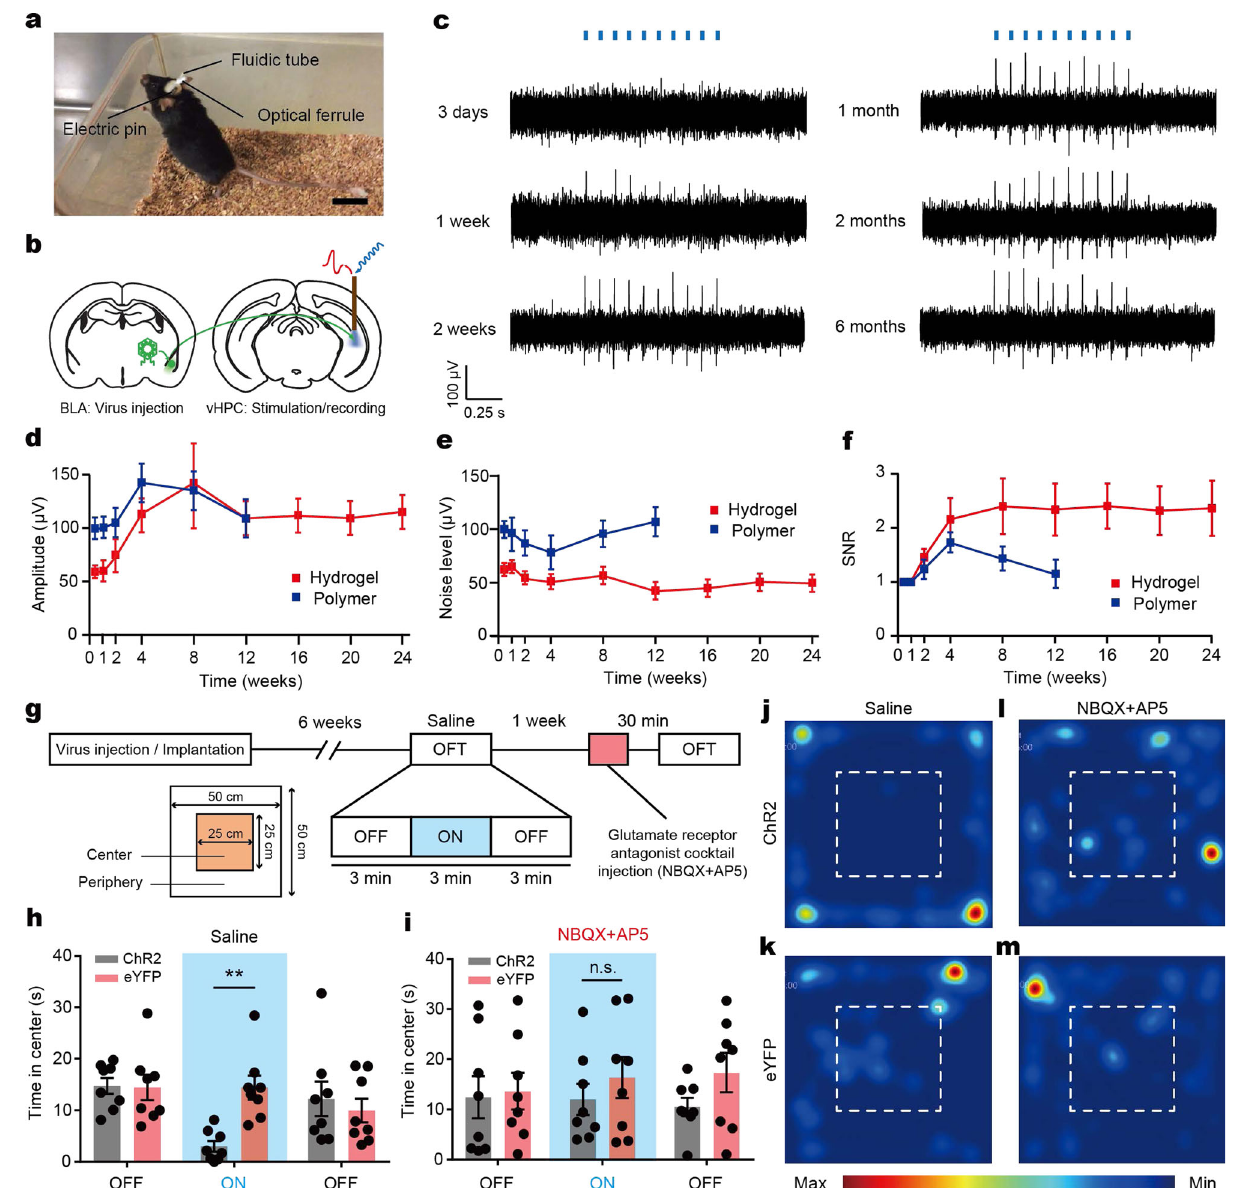
Fig. 3 Optogenetic interrogation by hydrogel hybrid probes. a A photograph of a mouse implanted with the hydrogel hybrid probe. Scale bar: 2 cm. b An illustration of optogenetic modulation and electrophysiological recording in the BLA-to-vHPC projection circuit. c Representative electrophysiological recordings in the vHPC during optical stimulation (10 Hz, 10 mW mm − 2 , 5 ms pulse width) using the hydrogel hybrid probes 3 days, 1 – 2 weeks, and 1 – 6 months following implantation and transfection with AAV5-CaMKII α ::ChR2-eYFP. d – f Amplitude of optically-evoked potentials ( d ) and background noise ( e ), and signal-to-noise ratio (SNR) ( f ) in the opto-electrophysiological experiments recorded from the hydrogel hybrid probes (red) and the polymer probes (blue) at various time point ( n = 8 for each). g A summary of the behavioral assays performed in this study. Open fi eld tests (OFT) are performed of the OFT arena during optical stimulation (20 Hz, 10 mW mm − 2 , 5 ms pulse width) is analyzed for trials conducted with the injections of saline solution or glutamate receptor antagonist cocktail (NBQX + AP5). Optical stimuli and drug injections are delivered into the vHPC via the hydrogel hybrid probes. h Time spent in the center in the absence or presence of optical stimulation following injection of saline solution (two-way ANOVA and Bonferroni multiple comparison test, p = 0.0031) i Time spent in the center in the absence or presence of optical stimulation following injection glutamate receptor antagonist cocktail (two-way ANOVA and Bonferroni multiple comparison test, p > 0.9999). j – m Representative heat map images tracing the position of mice transfected with ChR2 ( j , l ) and eYFP ( k , m ) control with injection of saline solution ( j , k ) and glutamate receptor antagonist cocktail ( l , m ). Dashed line indicates the center region of the open fi eld arena. Values in d – f , h , i represent the mean and the standard deviation ( n =